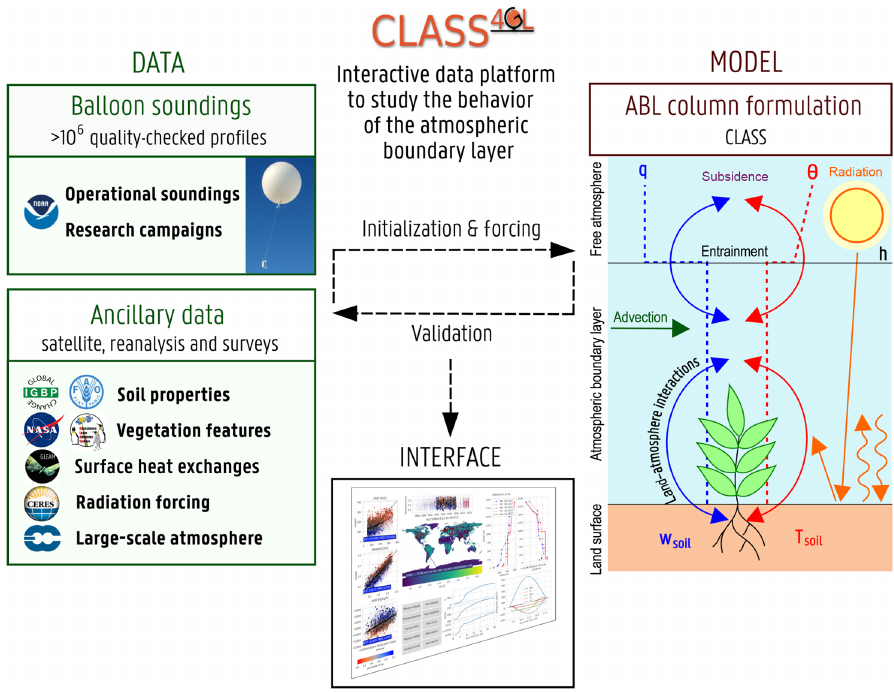
Figure 1. Schematic overview of the Chemistry Land-surface Atmosphere Soil Slab model for GLobal studies